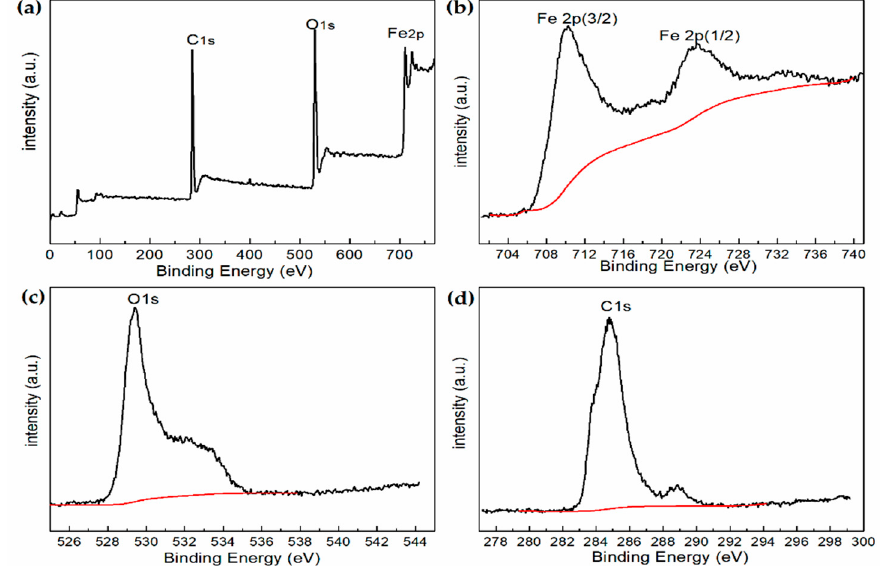
Figure 3. X-ray photoelectron spectroscopy (XPS) spectra of hollow Fe 3 O 4 @RGO ( a ), Fe2p spectrum ( b ), O1s spectrum ( c ), C1s spectrum ( d ).